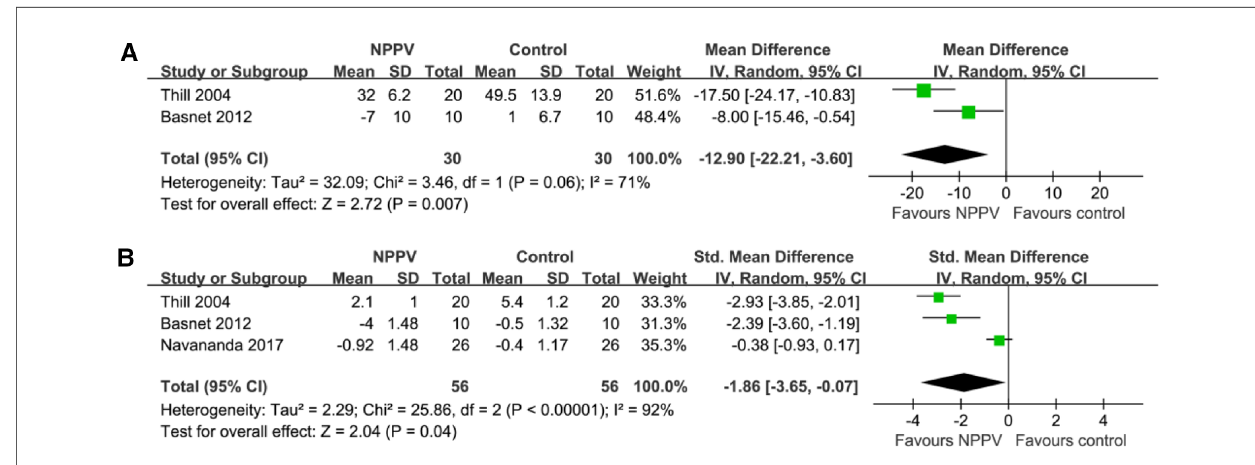
FIGURE 3 Forest plots for the meta-analysis evaluating the in fl uences of NPPV on acute changes of RR and symptoms score in children with acute asthma; ( A ) Meta-analysis for the in fl uences of NPPV on acute change of RR; and ( B ) meta-analysis for the in fl uences of NPPV on acute change of symptoms